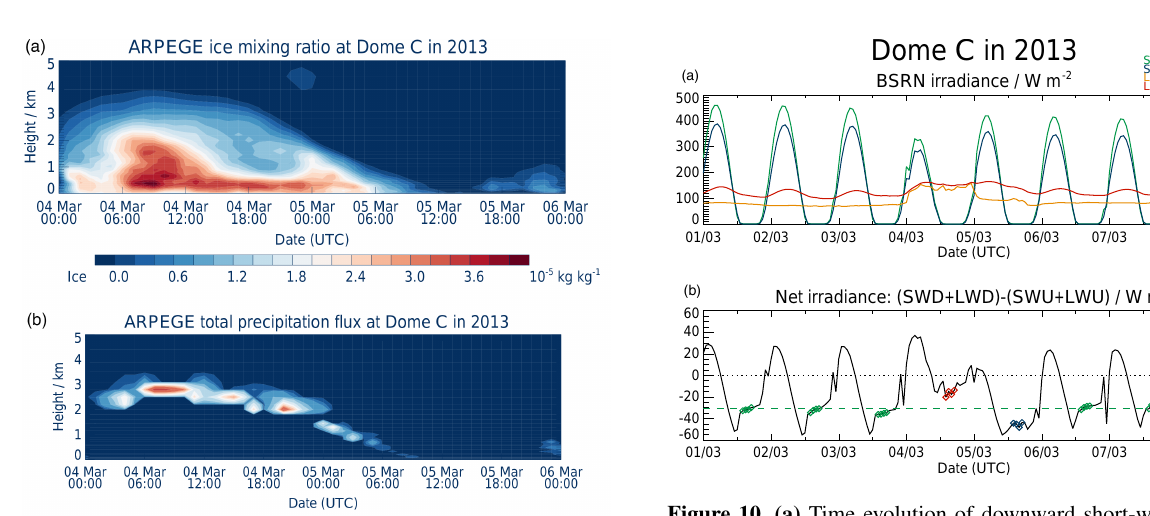
Figure 10. (a) Time evolution of downward short-wave radiation (SWD, green line), upward short-wave radiation (SWU, blue line), downward long-wave radiation (LWD, orange line) and upward long-wave radiation (LWU, red line) from 1 to 9 March 2013 above Dome C as measured by the BSRN instruments. (b) Net irradi- ance (SWD + LWD − SWU − LWU) as measured by the BSRN in- struments. The horizontal green dashed line represents the net ir- radiance averaged between 14:00 and 17:00UTC (represented by green diamonds) from 1 to 8 March excluding 4 and 5 March. The red and blue diamonds represent the net irradiances measured be- tween 14:00 and 17:00UTC on 4 March (thick cloud episode) and 5 March (diamond dust/ice fog episode),